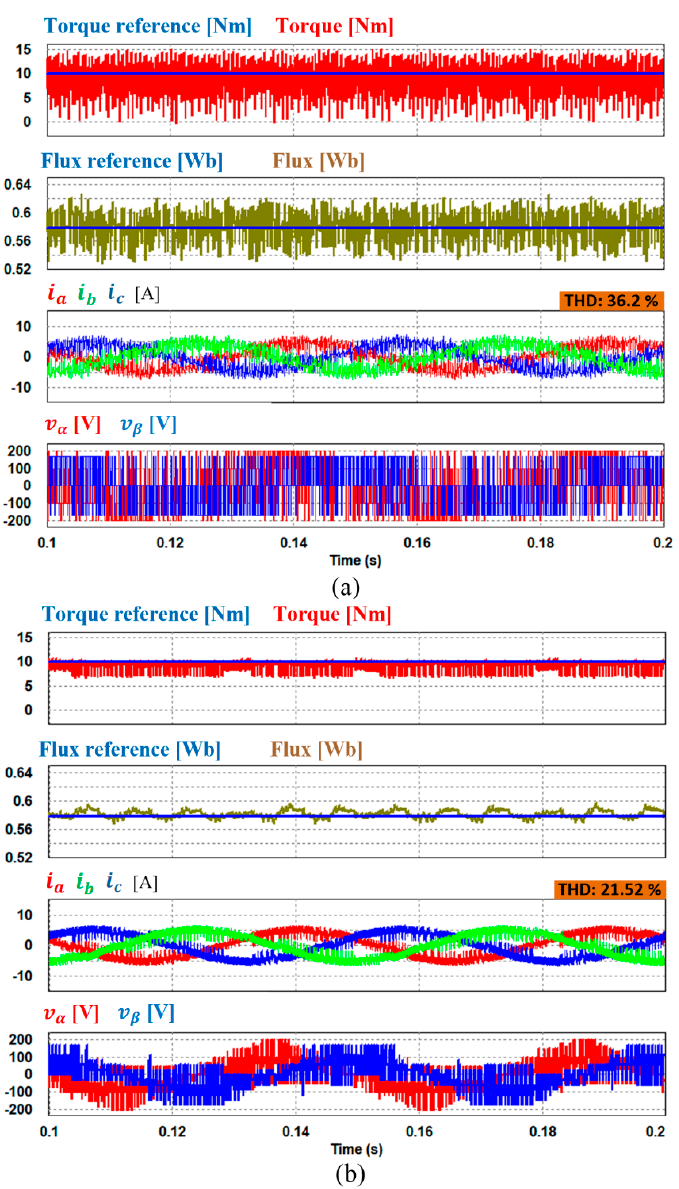
Figure 7. Simulation results for the steady-state response of the PMSM at 400 rpm, 10 Nm. ( a ) Conventional FS-PTC; ( b ) proposed PTC-DSVM.